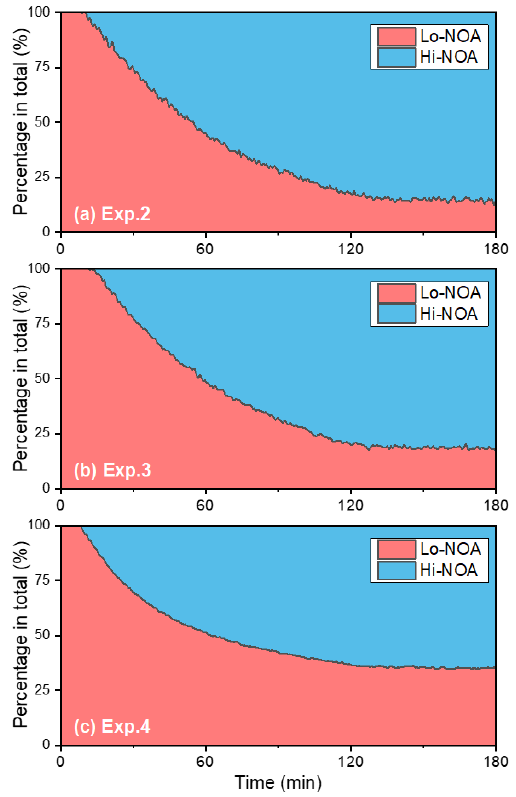
Figure 6. The evolution of high-nitrogen OA (Hi-NOA) and low- nitrogen OA (Lo-NOA) during the photooxidation process under different NO x / NH 3 concentrations. Hi-NOA and Lo-NOA were not consistent among experiments. (a) Exp. 2 with 200ppb NH 3 , (b) Exp. 3 with 200ppb NH 3 and 62ppb NO 2 , and (c) Exp. 4 with 63ppb NO 2 .